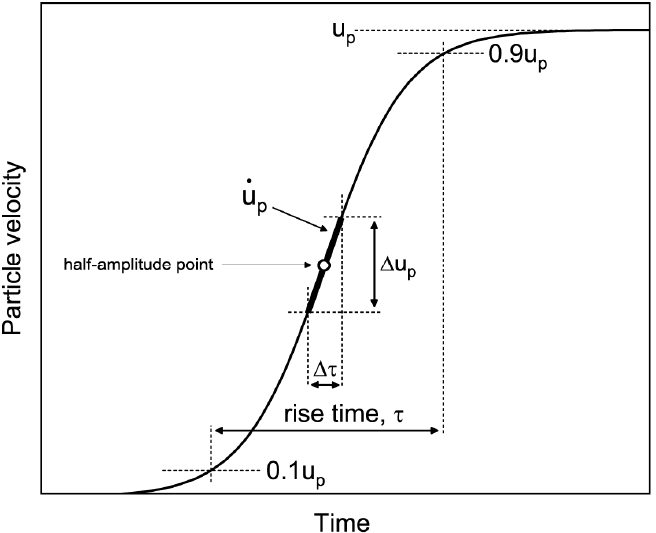
Figure 5. The idealized particle velocity profile demonstrating the calculations of the maximum particle velocity gradient and rise time. The thick line segment had a slope equal to a maximum particle velocity gradient. u p is the particle velocity behind a wave front.